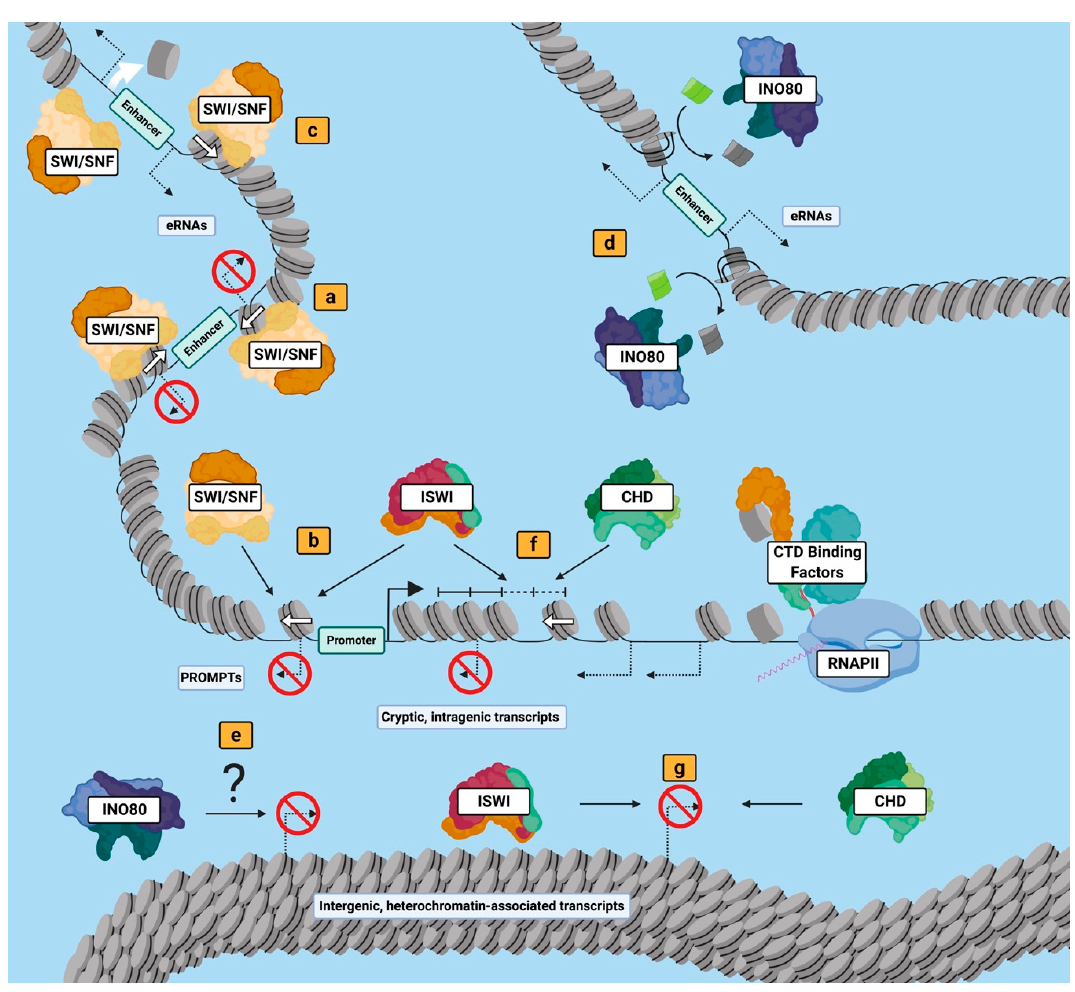
Figure 2. Mechanisms of ncRNA regulation by nucleosome remodelers of the four major subfamilies in higher eukaryotes. (a–c) Nucleosome remodelers from the SWI/SNF family utilize nucleosome sliding (a) and (b) and nucleosome eviction (c) to promote or suppress expression of ncRNAs associated with regulatory elements (eRNAs and PROMPTs). (d,e) Members of the INO80 family regulate promote PROMPT expression through nucleosome editing (d) but suppress heterochromatin-associated transcripts through less well-understood mechanisms (e). (f–g) Nucleosome remodelers of the ISWI and CHD families modulate nucleosome positioning to establish evenly spaced arrays of nucleosomes, to suppress intergenic (e) and intragenic (g) ncRNA expression. Figure created with Biorender.com.